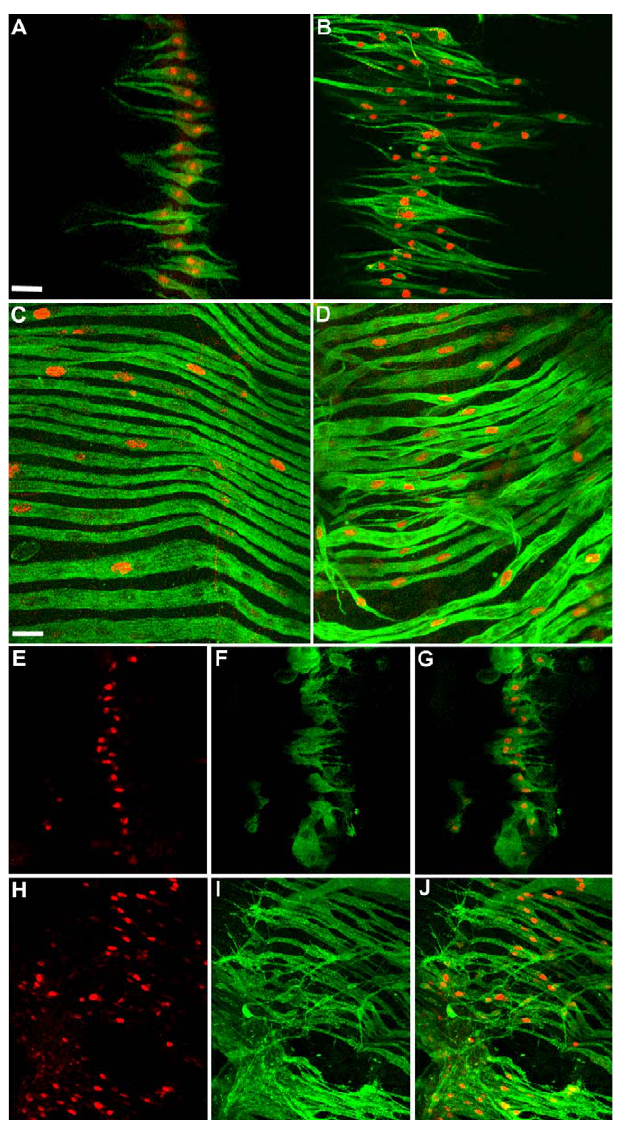
Figure 6. Over-Expression of Hbr/Dof and Htl (A–D) Increase in founder and fibre number upon over-expression of Hbr/Dof in myoblasts. (A and B) Pupae 28 h APF (grown at 29 8 C) double- labelled with anti- b -galactosidase (red) and 22C10 (green). (A) duf-lacZ pupa showing wild-type pattern of founders in a lateral hemi-segment. There are 19 founders present in the field of view. (B) 1151/duf-lacZ; UAS- dof/ þ pupa. Compared to the wild-type, an excess number of founder cells ( ; 42) are present in the mis-expression pupa. (C and D) Pupae 42 h APF (grown at 29 8 C) double-labelled with anti- b -galactosidase (red) and anti-MHC (green). (C) duf-lacZ pupa showing lateral muscles in a hemi- segment. (D) 1151/duf-lacZ; UAS-dof/ þ pupa showing excessive fibre formation. (E–J) Expression of Dof levels upon activation of Htl. Preparations of duf- lacZ (E–G) and 1151/duf-lacZ; UAS- k htl/ þ (H–J) pupae double-labelled with anti- b -galactosidase (red) and anti-Dof (green) at 28 h APF (grown at 29 8 C). For both pupae, images have been acquired at identical conditions. (E) Lateral founders in one hemi-segment of a duf-lacZ pupa. (F) Dof expression in the lateral founders. (G) Merged image of (E) and (F). (H) Lateral founders in an 1151/duf-lacZ; UAS- k htl/ þ pupa, showing an increase in founder number. (I) Dof expression in the same pupa. Dof is expressed in the extra founder cells. Also, level of Dof protein in the founders is higher than in the wild-type founders (in F). (J) Merged image of (H) and (I). Anterior is at top; dorsal midline is at right. Scale ¼ 30 l m (A, B, and E–J), 20 l m (C and D). DOI: 10.1371/journal.pbio.0030337.g006 PLoS Biology |